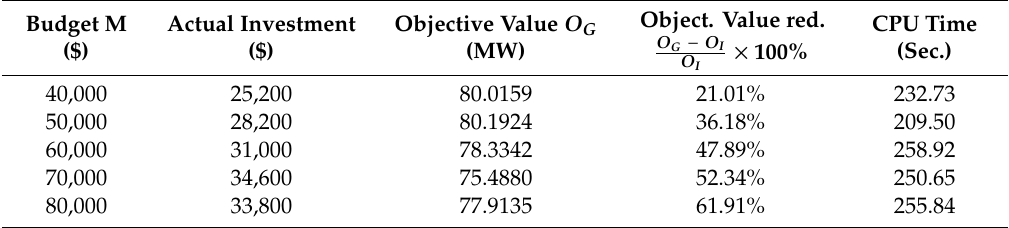
Table 7. Results on the IEEE 118-bus system using the GA.